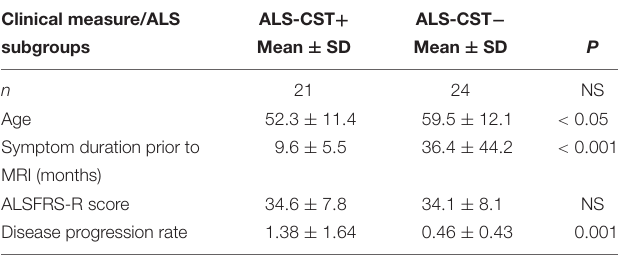
TABLE 1 | Clinical parameters of ALS patients.